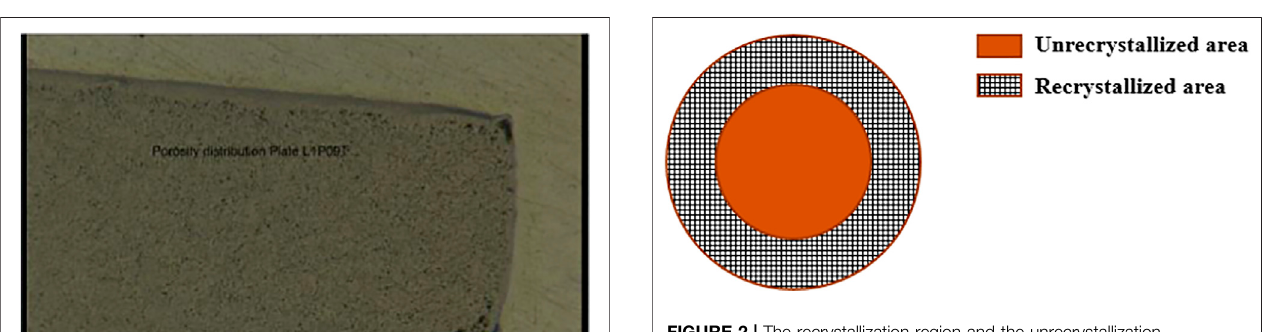
FIGURE 2 | The recrystallization region and the unrecrystallization